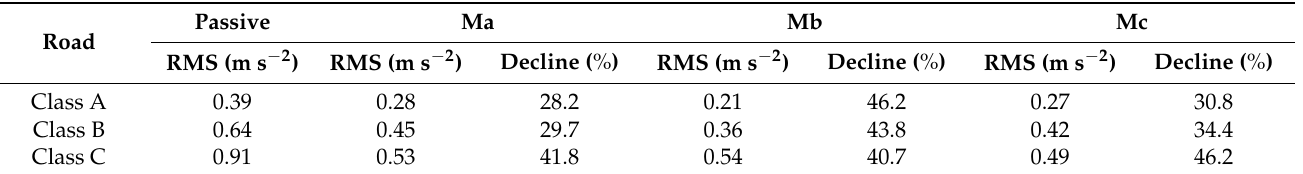
Figure 6. Time response comparison of body acceleration under different road conditions. Table 8. RMS values of body acceleration for time response to a random excitation under different road